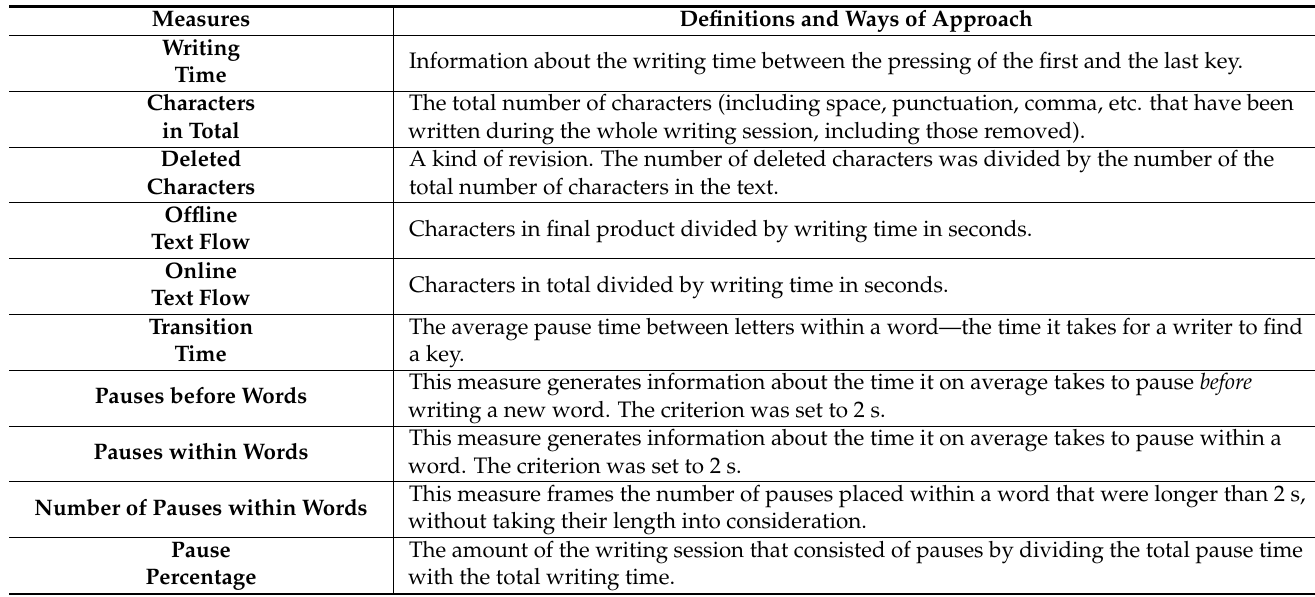
Table 3. The writing process measures, with